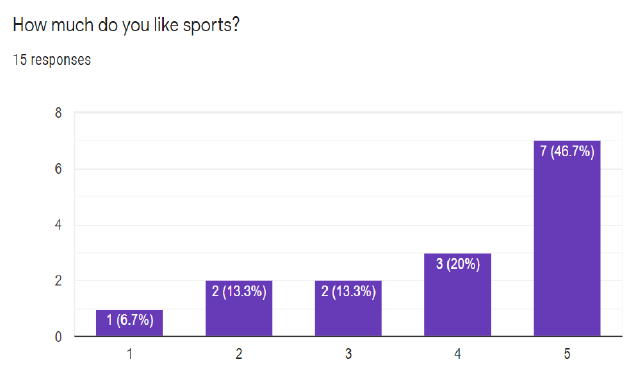
Figure 15. Respondents who enjoy